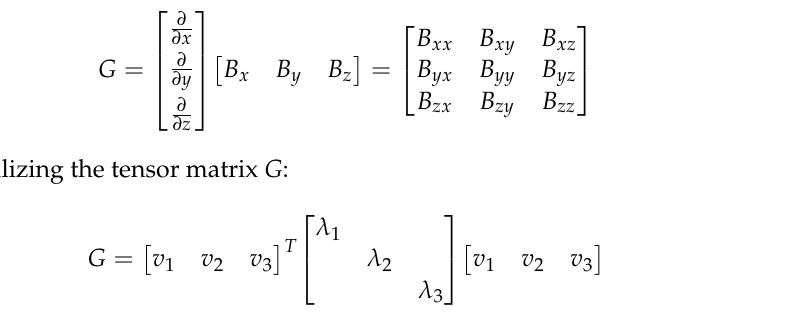
Diagonalizing the tensor matrix G :